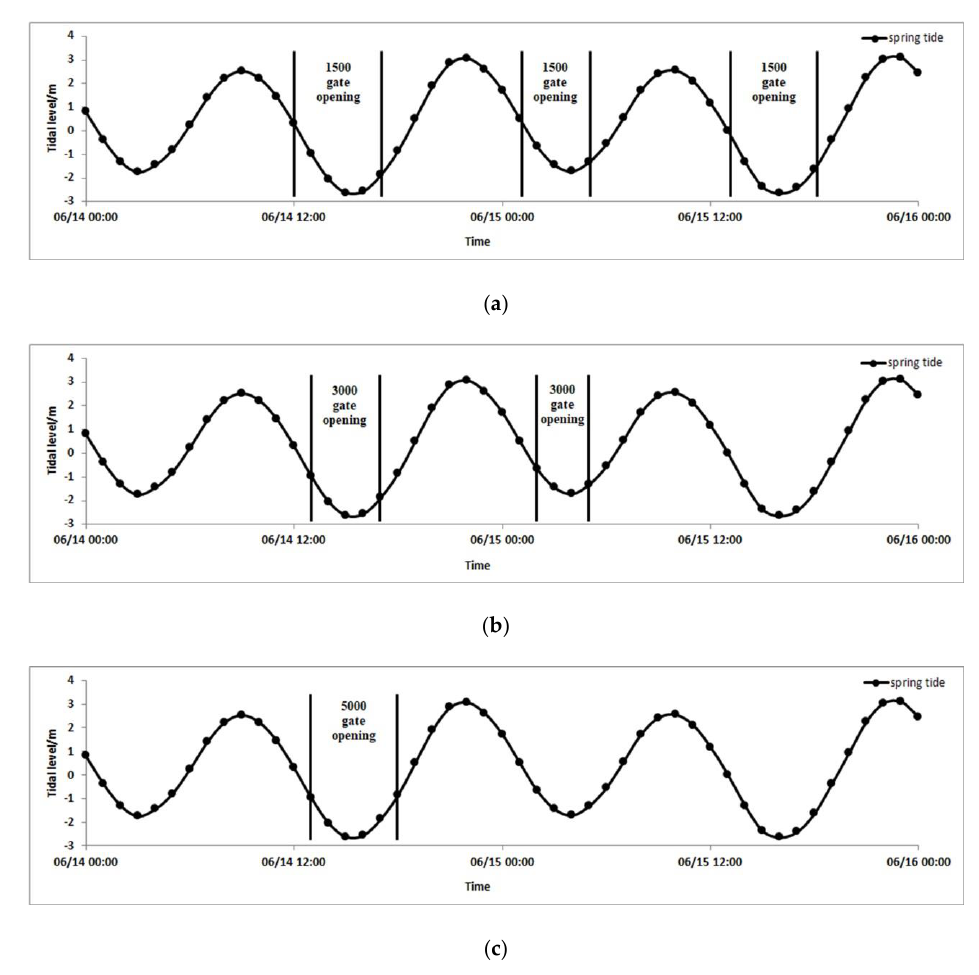
Figure 6. Dispatch diagram of gate control boundary discharging with flow of ( a ) 1500 m 3 / s, ( b ) 3000 m 3 / s and ( c ) 5000 m 3 / s, respectively during spring